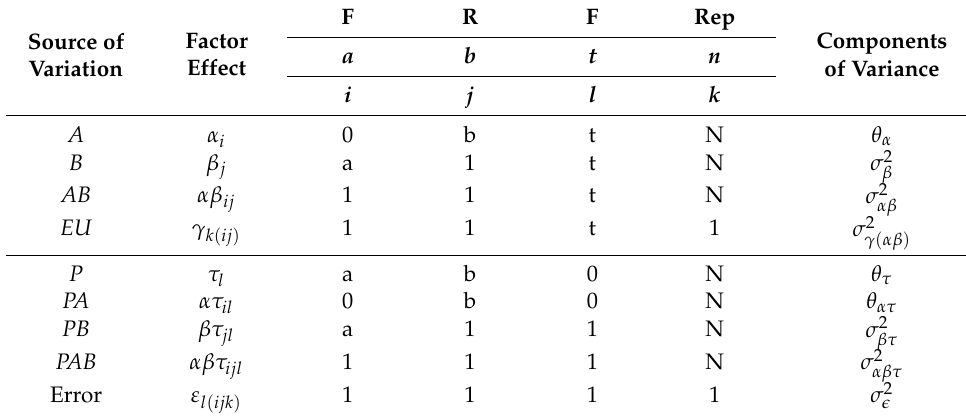
Figure 1. Process of constructing coefficients of variance components. Table 1. Variance components for a three-factor repeated-measures